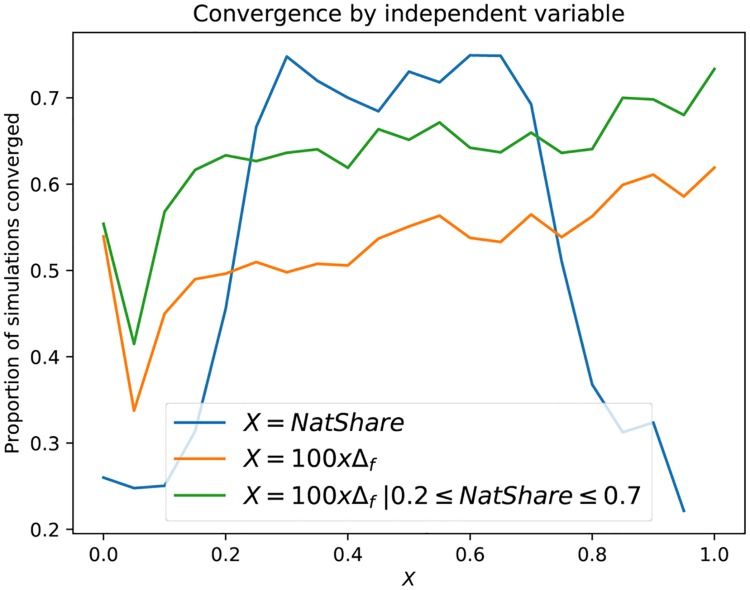
Proportion of sample paths that test positively for convergence by independent variable.Each variable X is binned into intervals of size 0.05, and then we count the fraction of sample paths which pass the test within each bin.